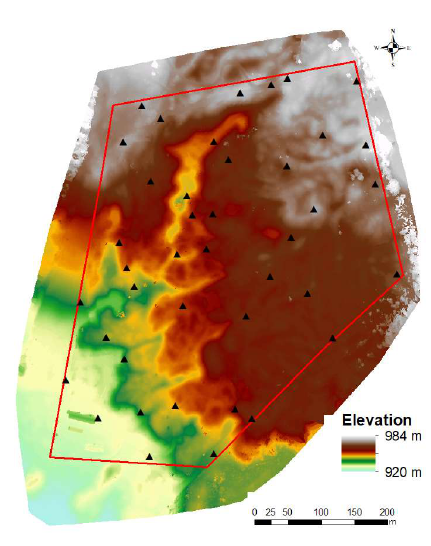
Figure 3. GCPs (black triangle) in the study area (red polygon)